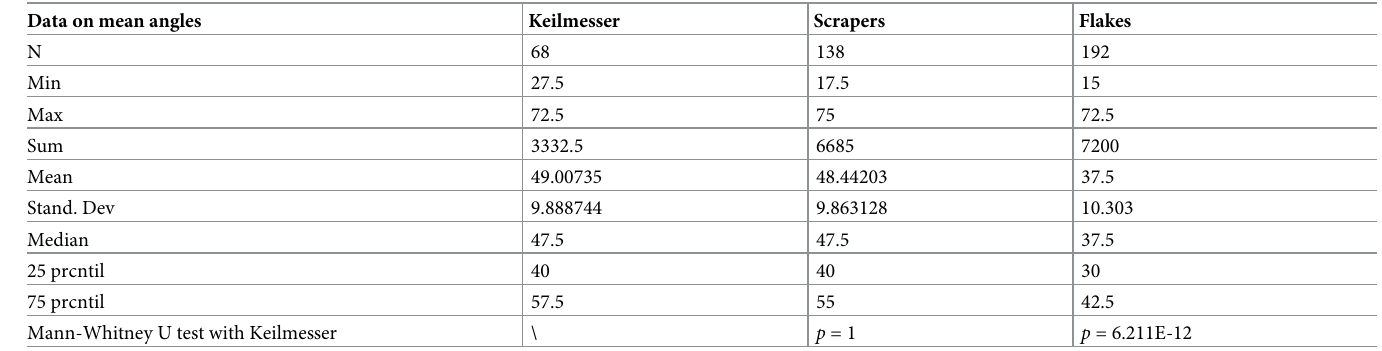
Table 8. Data on cutting edge mean angles of Keilmesser, scrapers and backed flakes.